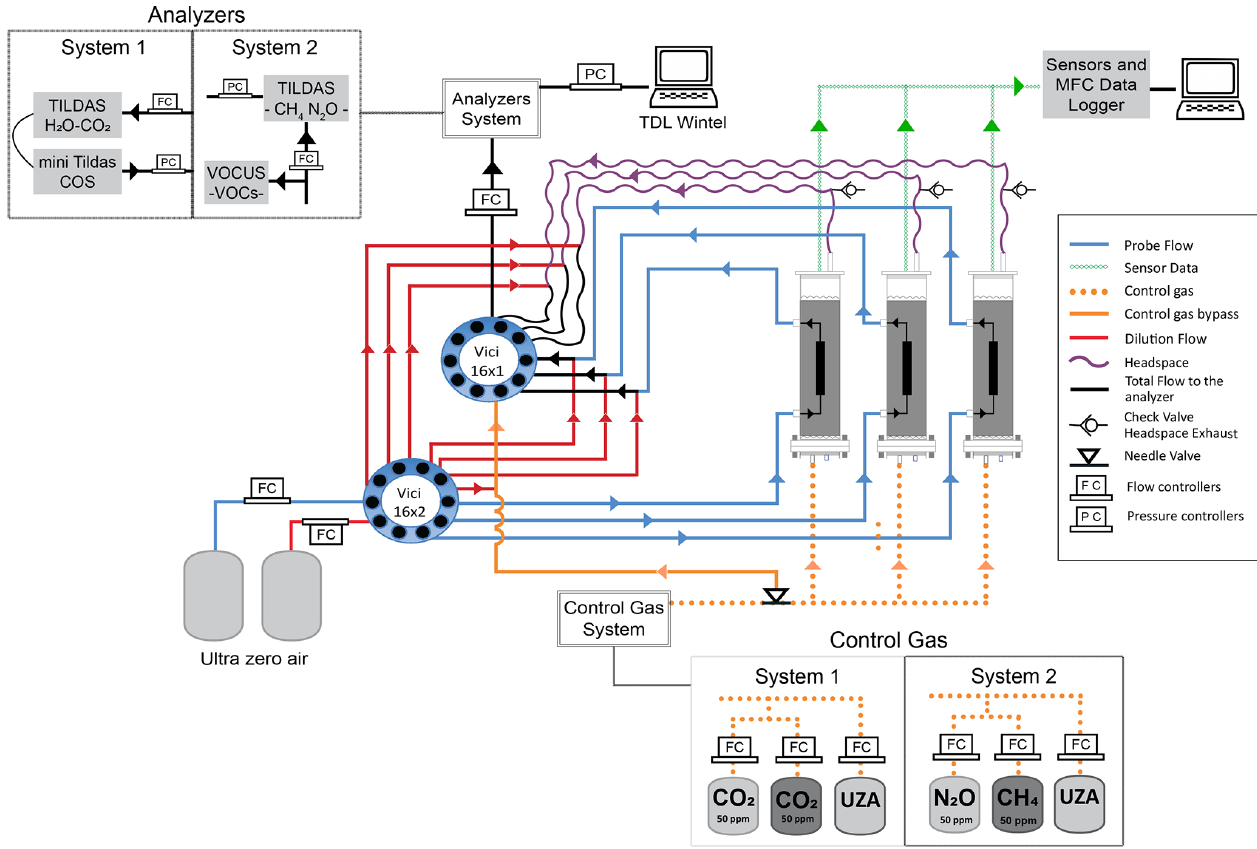
Figure 2. Detailed schematic of sampling System 1 (UA) and System 2 (ARI). Column matrix gas concentrations were controlled by mixing cylinder gas with UZA using MFCs and delivering the custom gas mixture through the columns from bottom to top (dotted orange line). Probe sampling flow rates were controlled precisely using three MFCs to ensure that flow in and out of the probe was balanced (probe flow (blue lines) + dilution flow (red lines) is equal to total flow to analyzer (black lines)). Column headspace (atmospheric pressure) and control gas bypass (positive pressure) were controlled by MFCs at two points (dilution, total flow to analyzer), forcing the probe flow as a makeup flow (probe flow is equal to total flow minus dilution